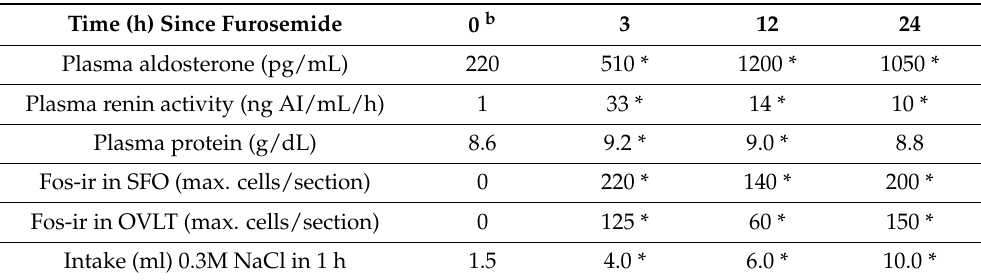
Table 2. Temporal changes of physiological parameters and sodium appetite following acute sodium depletion in rats a